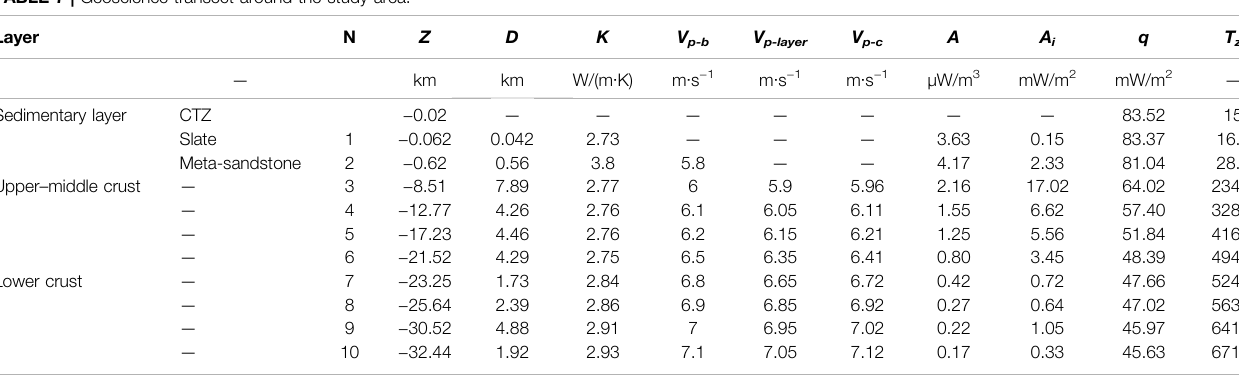
TABLE 7 | Geoscience transect around the study area.